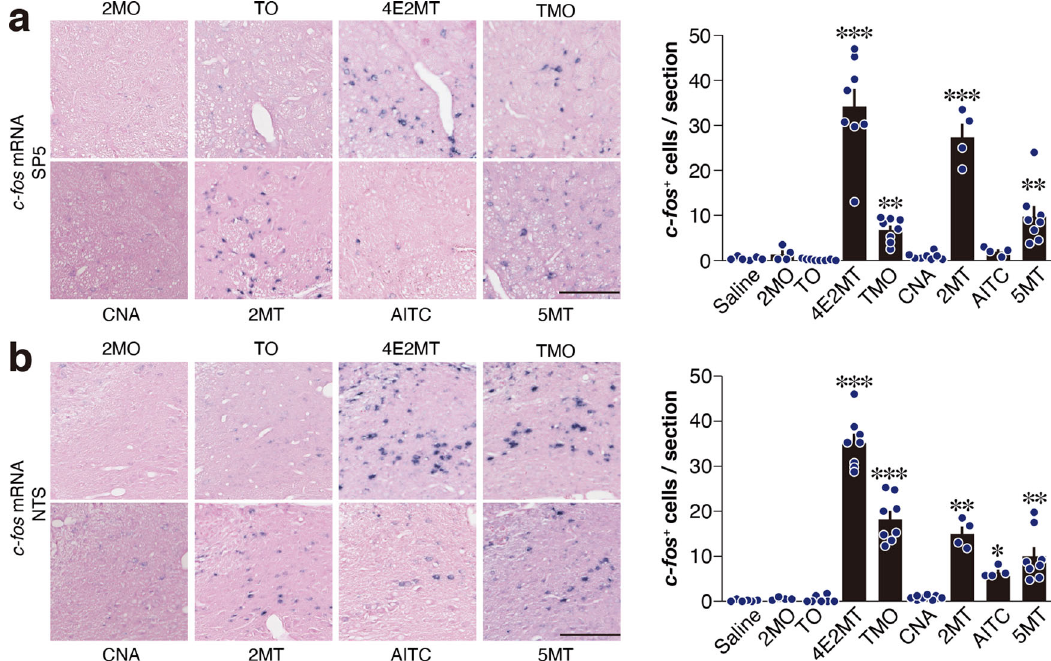
Fig. 8 Sp5/NTS activation by various compounds. a , b Representative images of in situ hybridization of c-fos mRNA (left) and quanti fi cation of c-fos- positive cells (right) in the Sp5 ( a ) and NTS ( b ) in response to IP injection of the indicated compounds ( n = 6 for saline, n = 4 for 2MO, 2MT, and AITC, and n = 8 for TO, 4E2MT, TMO, CNA, and 5MT; a , p = 0.5447 for 2MO, p = 0.5745 for TO, p < 0.0001 for 4E2MT, p = 0.0071 for TMO, p = 0.4904 for CNA, p = 0.0005 for 2MT, p = 0.2331 for AITC, and p = 0.0028 for 5MT; b , p = 0.5148 for 2MO, p = 0.9379 for TO, p < 0.0001 for 4E2MT, p = 0.0001 for TMO, p = 0.2798 for CNA, p = 0.0034 for 2MT, p = 0.0447 for AITC, and p = 0.0043 for 5MT). Scale bar, 100 μ m. Data are shown as mean ± SEM. Kruskal – Wallis with uncorrected Dunn ’ s test was used to assess signi fi cance; * p < 0.05; ** p < 0.01; *** p <